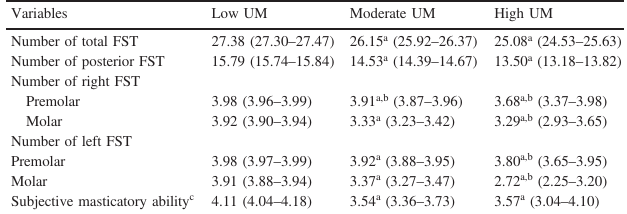
Table 2. Mean Functional Teeth (FST) and subjective